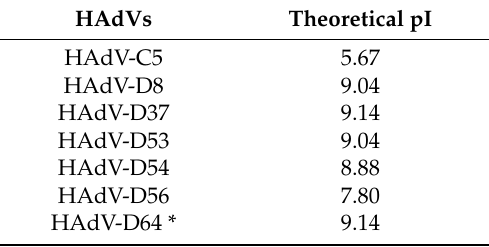
Table 1. Theoretical isoelectric points (pIs) of the FK domain of EKC-causing HAdVs. HAdVs Theoretical pI HAdV-C5